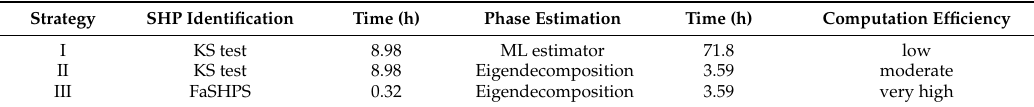
Table 1. Comparison of computational efficiency of three combined strategies for 1000 * 1000